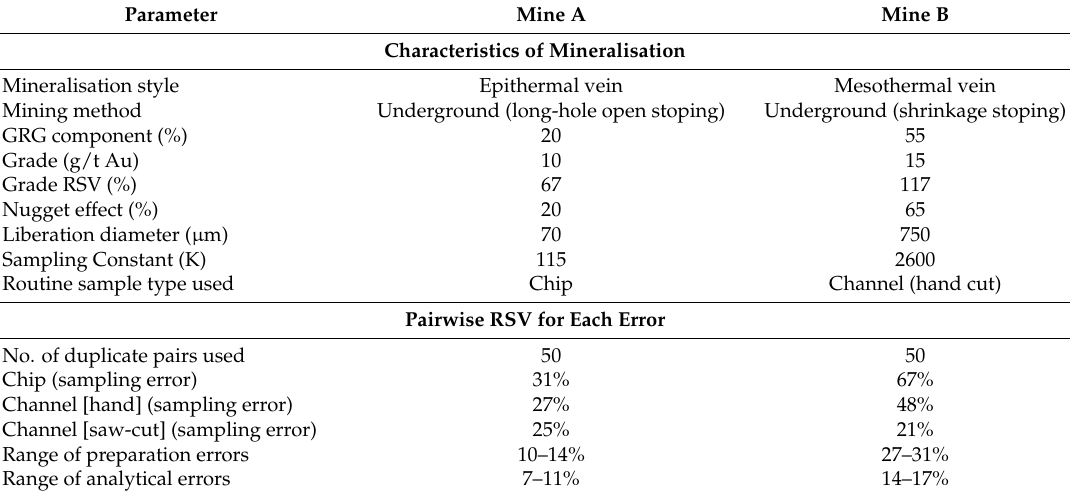
Table 24. Examples from South (Mine A) and North (Mine B) America showing error comparison between two differing styles of gold mineralisation